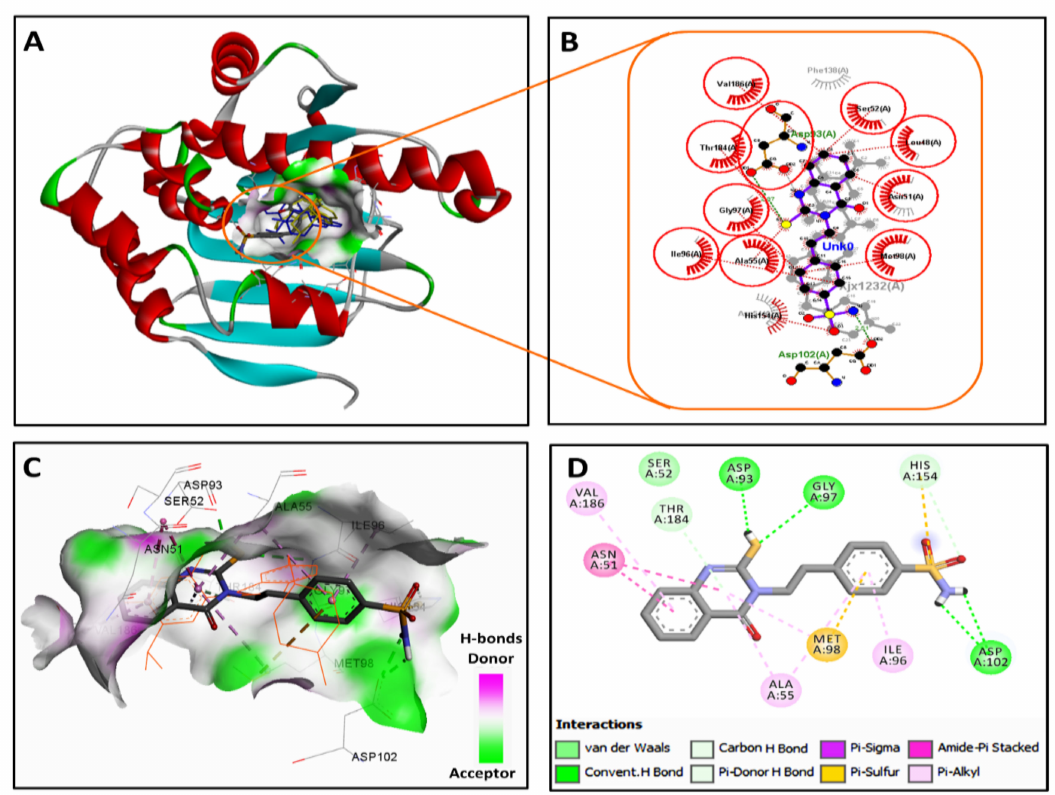
Figure 3. 2 / 3D binding modes of onalespib and HAA 2020 into the active site of Hsp90 (pdb code: 2XJX): ( A ) binding modes of the redocked onalespib (coloured in yellow), co-crystallized onalespib (coloured in blue) and HAA 2020 (coloured by element) into Hsp90, ( B ) LigPlot view showing the superposition of HAA 2020 and onalespib with two equivalent hydrogen bonds (shown as olive green dotted lines) with Asp93 and Asp102 and several equivalent hydrophobic interactions (shown as brick red dotted lines), ( C ) 3D binding mode of HAA 2020 (shown as sticks coloured by element) overlaid with onalespib (shown as orange lines) into the binding site of Hsp90, receptor shown as the hydrogen bond surface, hydrogen atoms omitted for clarity, and ( D ) 2D binding mode of HAA 2020 showing three conventional hydrogen bonds and di ff erent types of hydrophobic